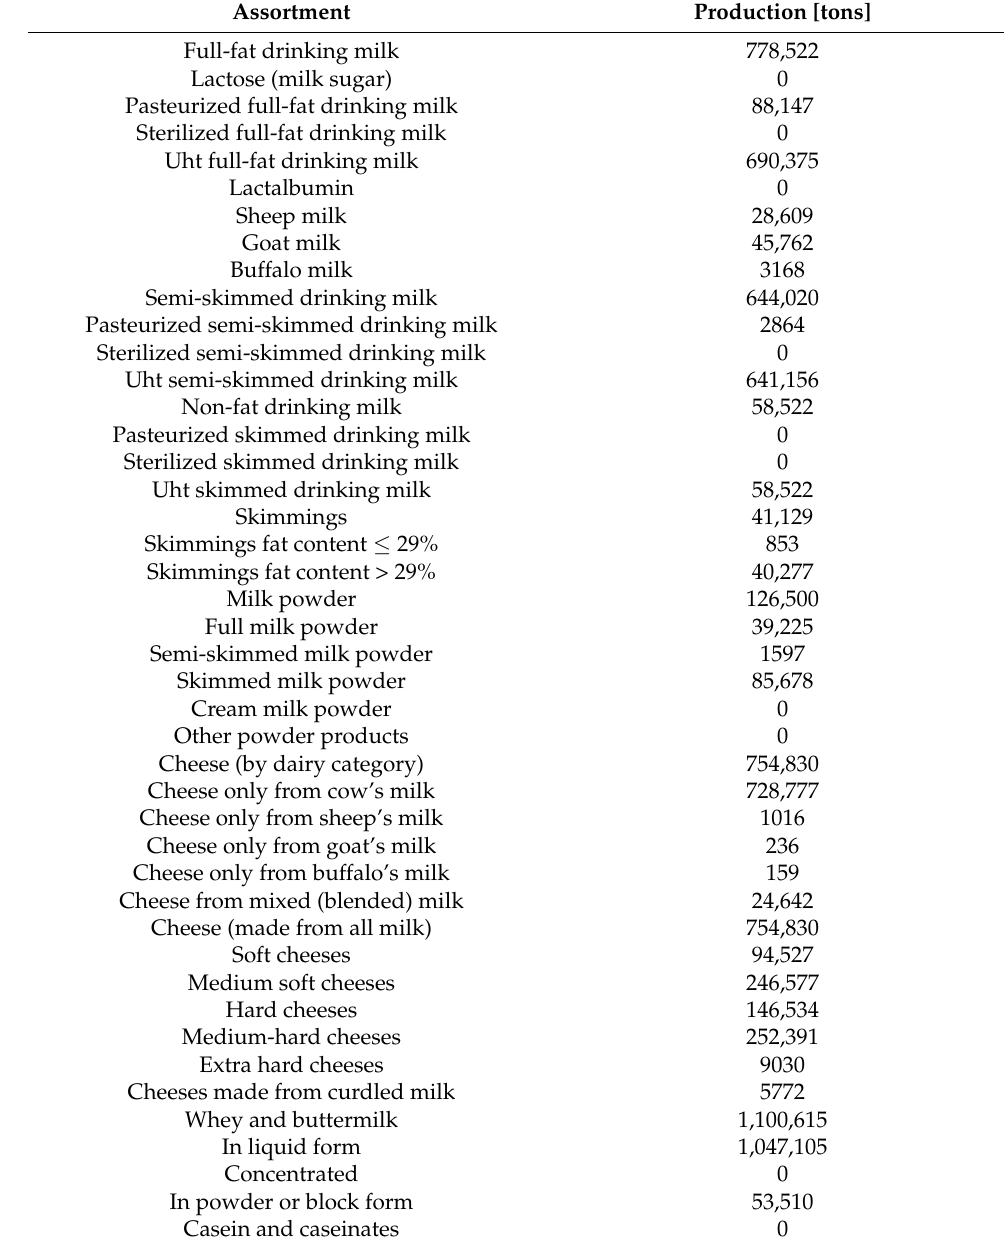
Table 6. Turkey’s milk and dairy product production in 2021 [33].